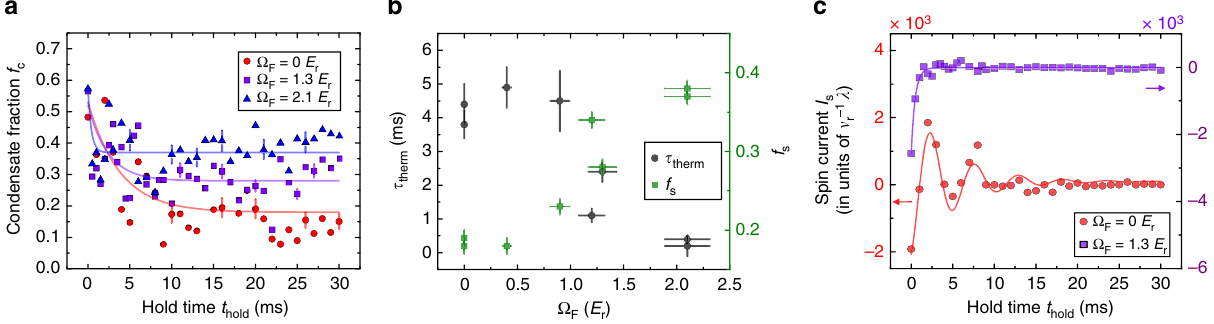
Fig. 4 Thermalization and spin current. a The measured condensate fraction f c = N c / N as a function of t hold for SDM in the bare case (no SOC, Ω F = 0) and the dressed cases (with SOC, Ω F = 1.3 E r and Ω F = 2.1 E r ). Representative error bars show the average percentage of the standard error of the mean. The solid curves are the shifted exponential fi ts to the smoothed f c (see Methods). The initial condensate fraction (not shown) at Ω I (measured at t hold = − 1 ms) is ~0.6 – 0.7 for all the cases. b The saturation time constant τ therm of the decreasing f c and the saturation condensate fraction f s versus Ω F , where the vertical error bar is the standard error of the fi t. c Spin current I s (normalized by v r / λ = 7.4 × 10 3 /s, where v r ~ 6 mm/s is the recoil velocity) as a function of t hold for Ω F = 0 and 1.3 E r . The solid curves are fi ts (see text)